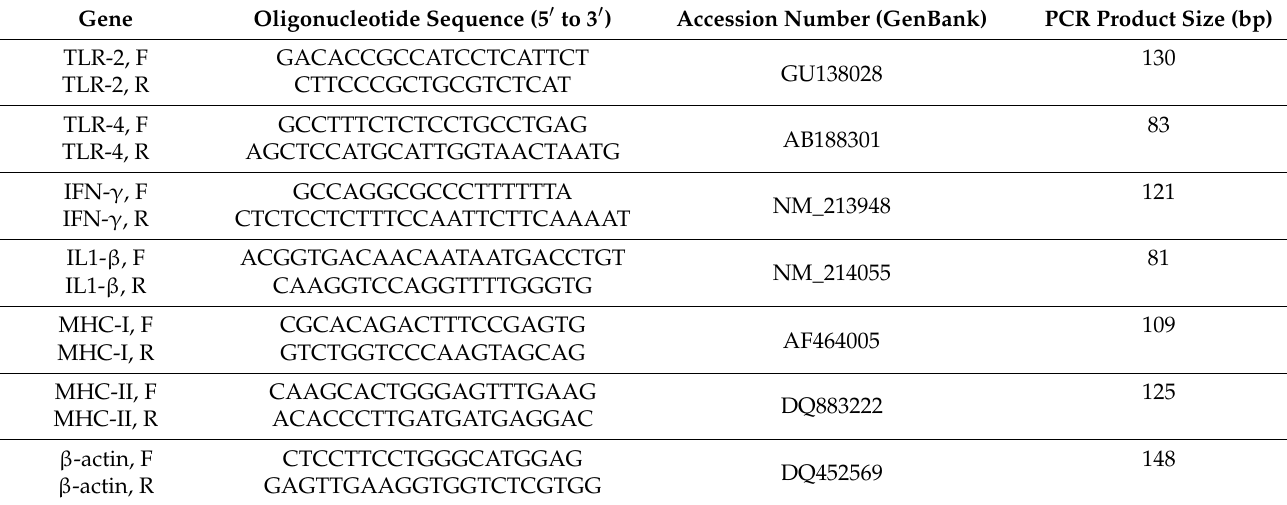
Table 9. Oligonucleotides used for real-time PCR reactions. Gene Oligonucleotide Sequence (5 (cid:48) to 3 (cid:48)